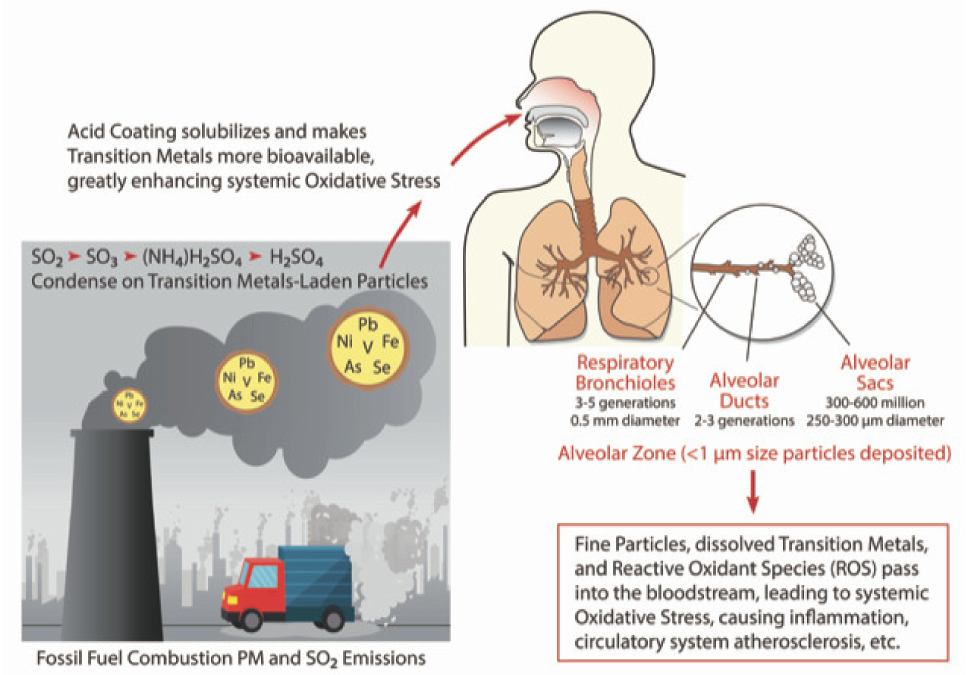
Figure 7. A causal pathway for systemic effects of fossil fuel combustion